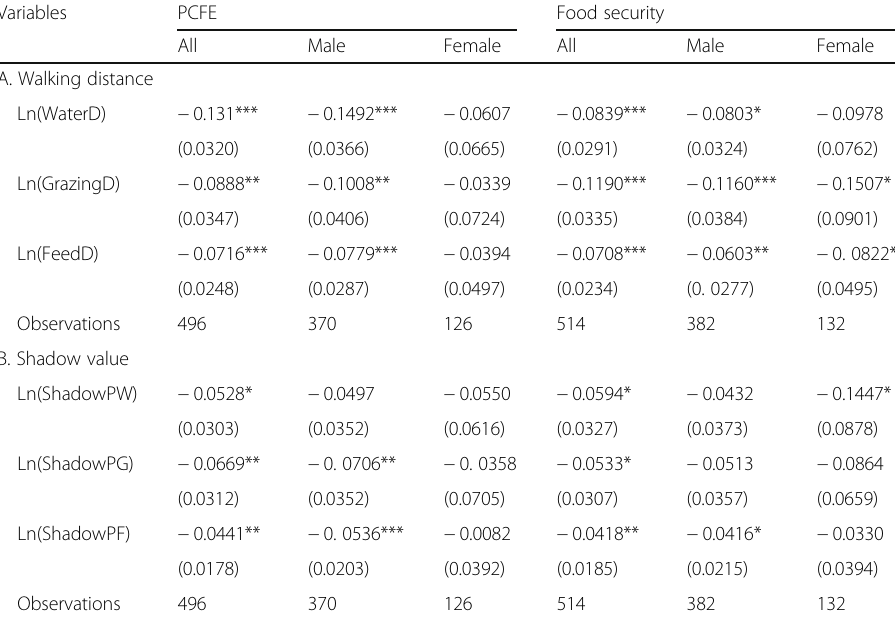
Table 5 Effect of water, grazing, and feed scarcity on log PCFE and food security Variables